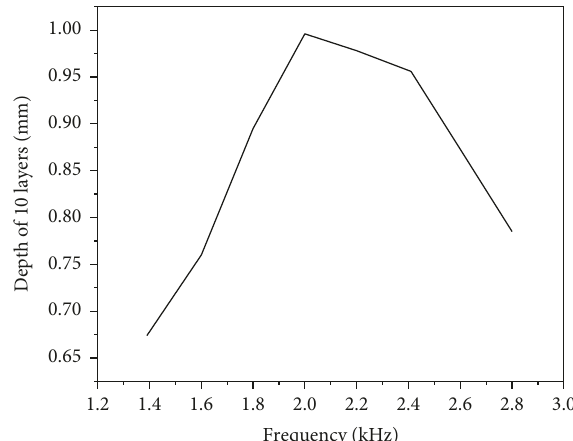
Figure 4: The relationship between laser pulse frequency and engraving depth.